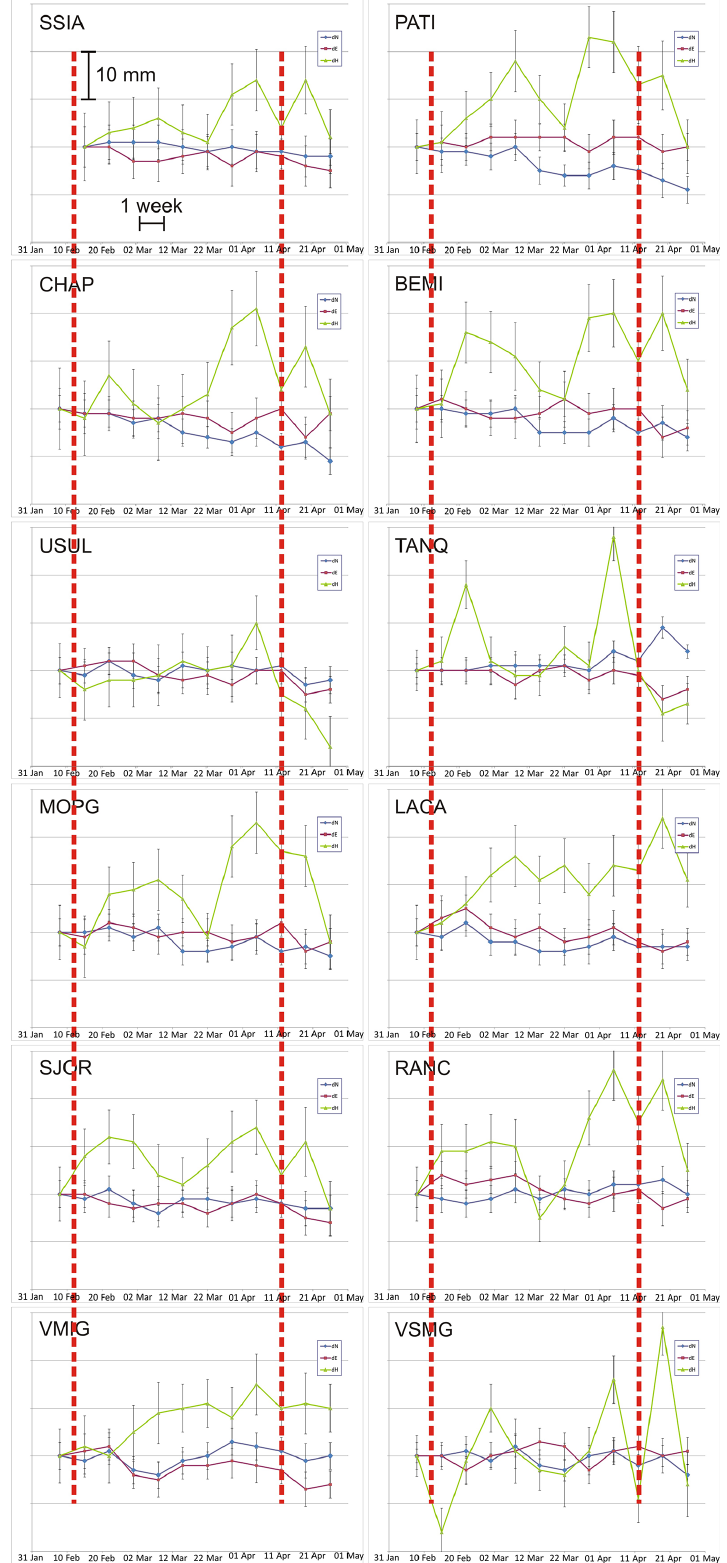
Figure 9. Weekly time series of the three components of displacements at the GPS stations. Vertical dashed lines indicate the occurrence of small ash emissions at the San Miguel